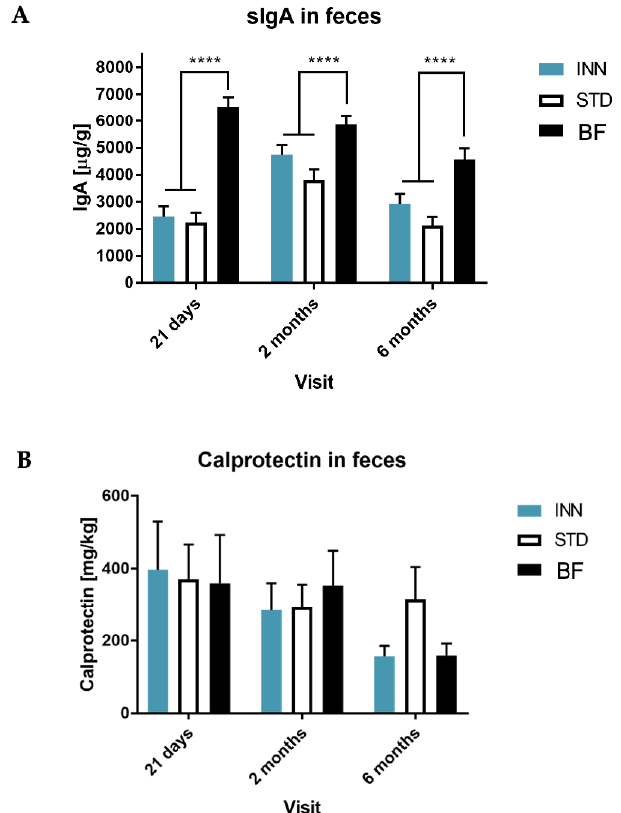
Figure 2. Secretory IgA and calprotectin in feces, including INNOVA formula (INN), standard for- mula (STD), and breastfeeding (BF) at 21 days, 2 months, and 6 months. A. IgA; B. Calprotectin. **** formula (STD), and breastfeeding (BF) at 21 days, 2 months, and 6 months. ( A ) IgA; ( B ) Calprotectin. p < 0.0001. **** p <